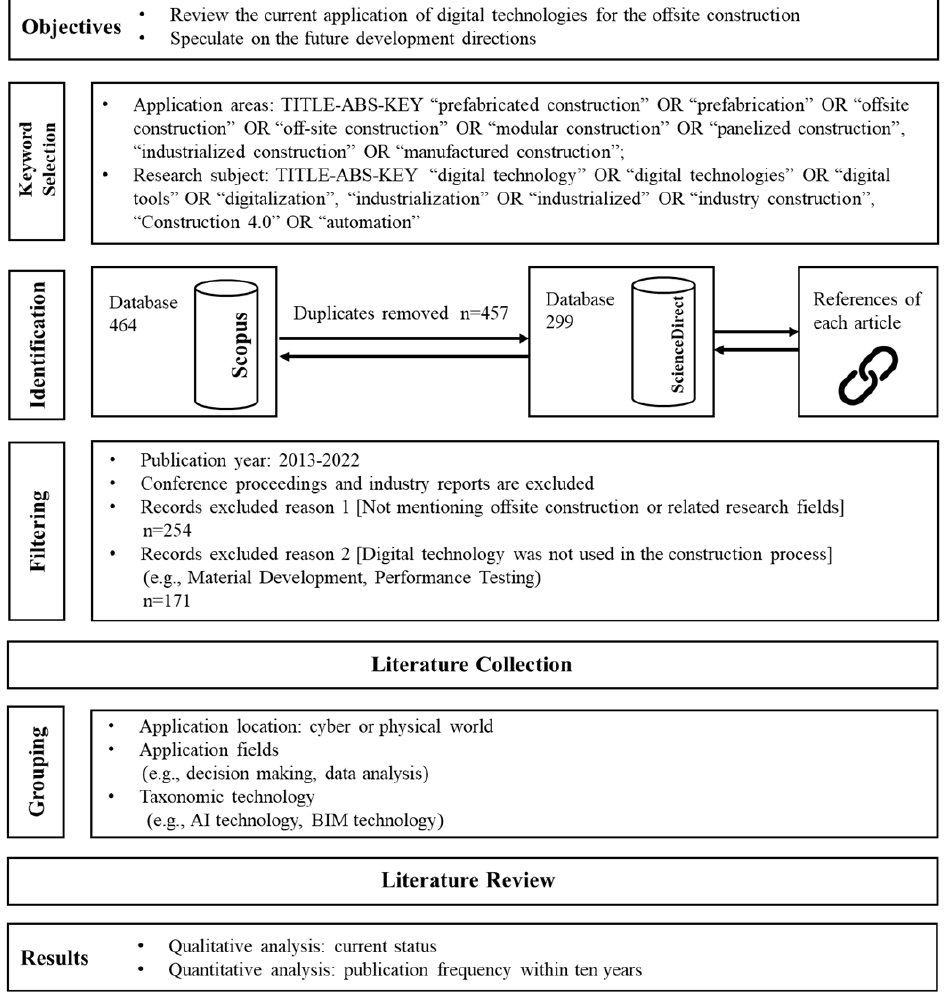
Figure 1. Methodology.